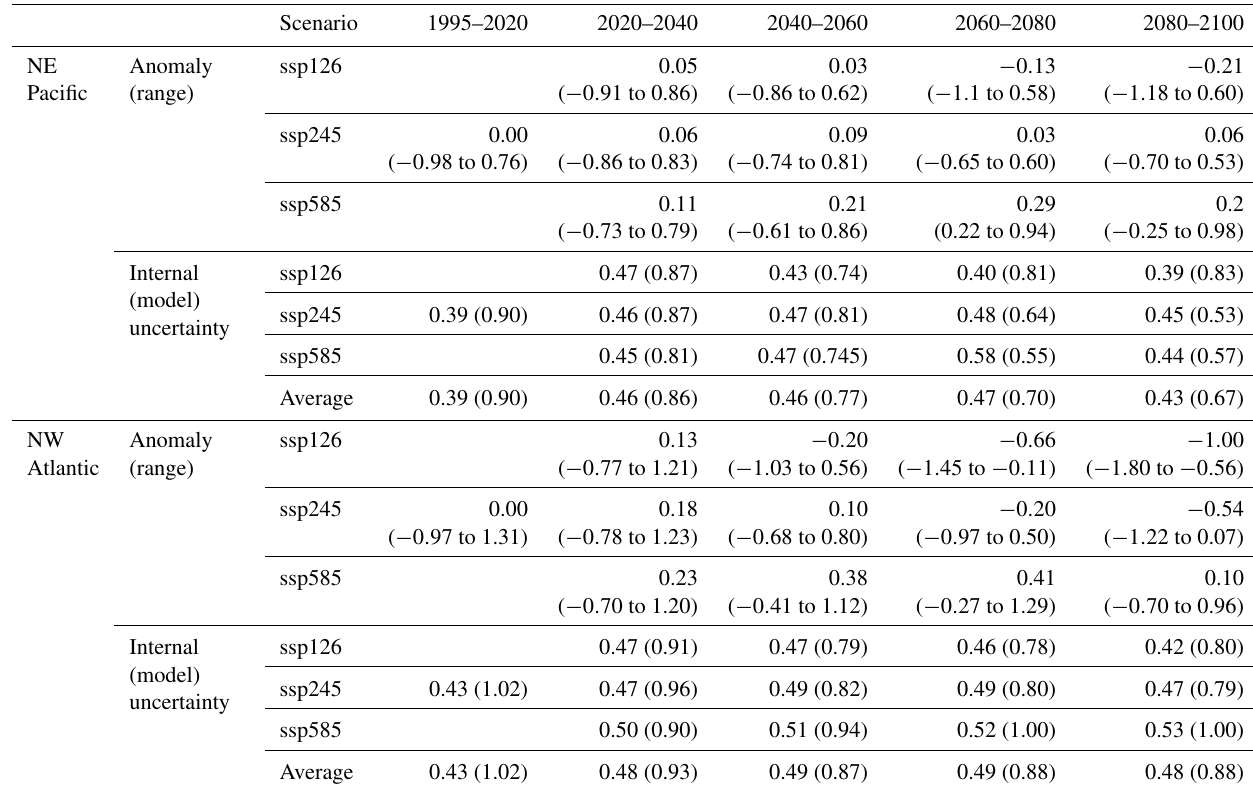
Table 2. CMIP6 multi-model mean sink anomalies (with ranges in parentheses) relative to 1995–2015 mean (in molCm − 2 yr − 1 ) and internal variability (with model uncertainty in parentheses) for the three scenarios and their average values in NE Pacific and NW